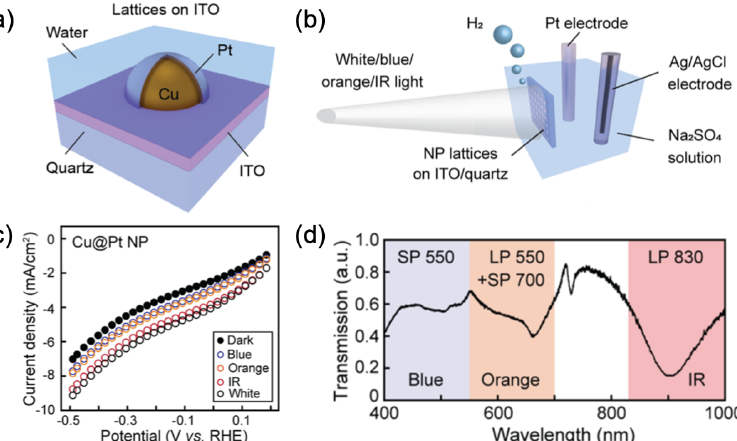
Figure 7. ( a ) Principle scheme of the unit cell of the metasurface. ( b ) Illustration of HER measurements. ( c ) Linear sweep voltammogram scans of HER at different wavelengths (see the caption in the curves). ( d ) Transmission spectrum of the Cu@Pt nanoparticle array, where three ranges of light are indicated by the shading of each. All the figures are reprinted (adapted) with permission from [87], Copyright 2021 American Chemical Society.